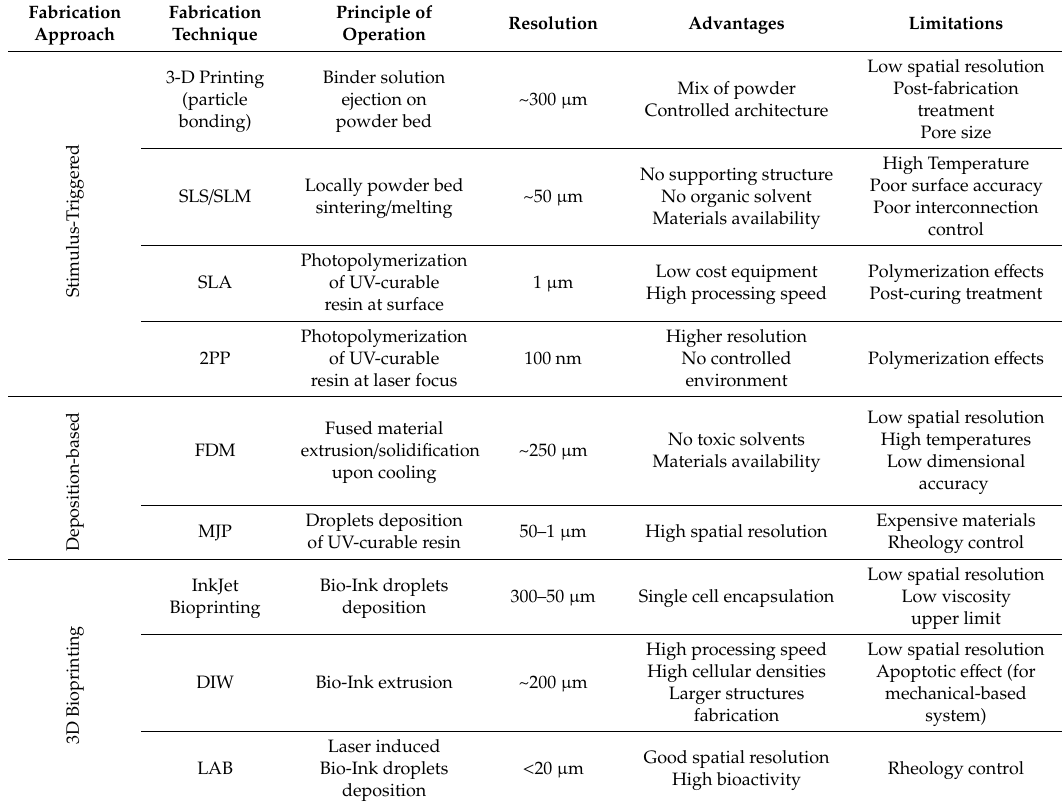
Table 1. Summary of additive manufacturing techniques for sca ff old